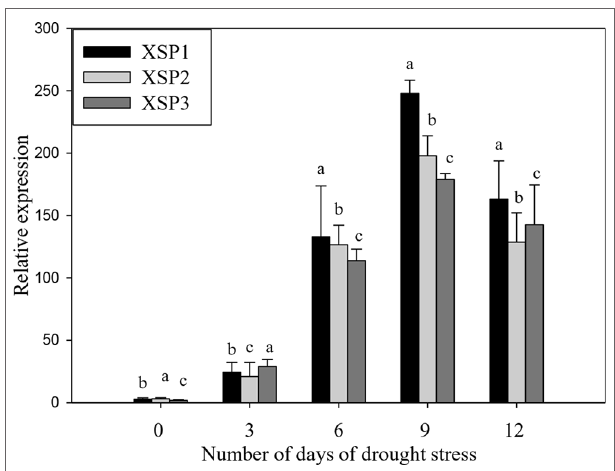
FIGURE 2 | Quantitative real-time PCR (qRT-PCR) analysis of XvSap1 transcript levels in leaves of transgenic sweet potato XSP1, XSP2, and XSP3 transgenic lines during 12-day water deficit stress. Means ± SE (standard error) followed by different alphabets in each growth condition are significantly different (P ≤ 0.05) using Fisher’s least significant difference (LSD). Data are from three independent replicates of the same event ( Table S4 ).